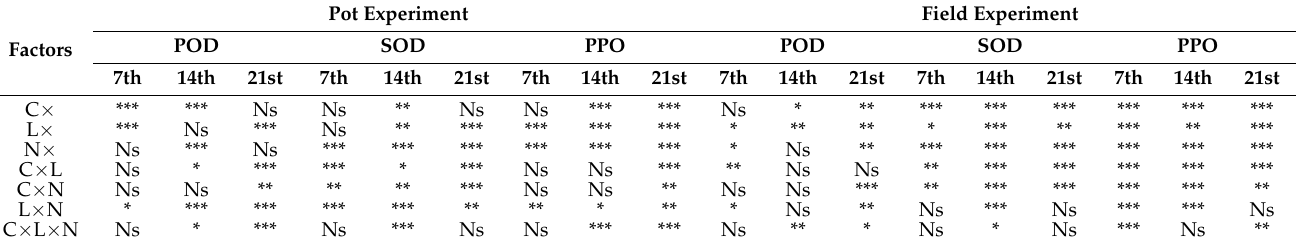
Table 2. Effect of C, N and L on POD, SOD and PPO activity during Pot and Field experiment.